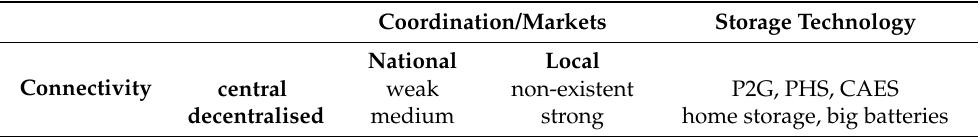
Table 1. Combinations of the connectivity and coordination define the possible energy system architectures with the respective storage technologies associated. Note: P2G = power to gas; PHS = pumped hydro storage; CAES = compressed air energy